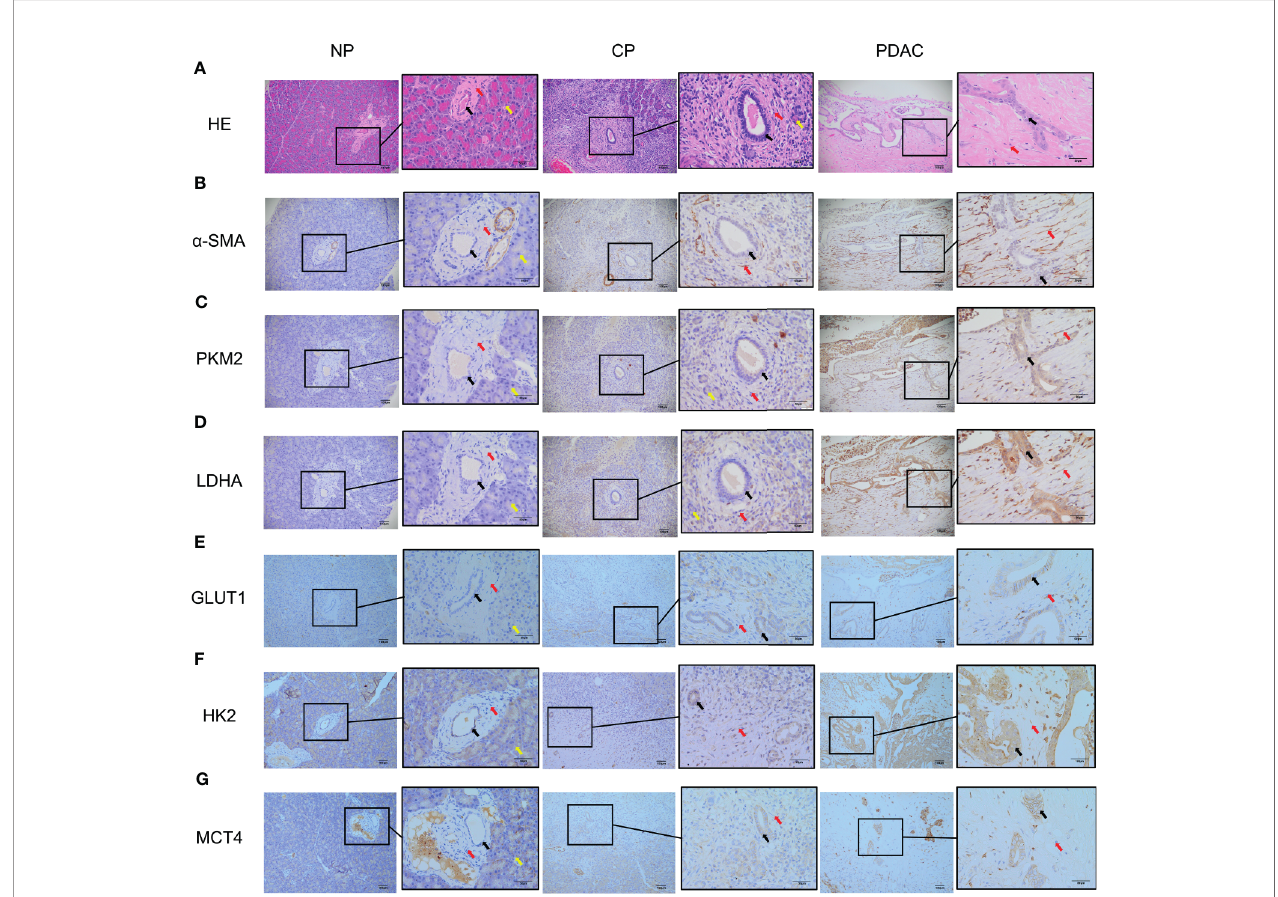
FIGURE 5 | Immunohistochemistry showed that the a -SMA and glycolysis markers in the pancreatic tissues of rats in the normal group, CP group and PDAC group gradually increased (100X and 400X; black arrow: normal/cancer epithelial duct cells; red arrow: stromal cells ( fi broblasts, PSCs); yellow arrow: acinar cells). (A) HE in normal/CP/PDAC rat pancreas; (B) a -SMA in normal/CP/PDAC rat pancreas; (C) PKM2 in normal/CP/PDAC rat pancreas; (D) LDHA in normal/CP/PDAC rat pancreas; (E) GLUT1 in normal/CP/PDAC rat pancreas; (F) HK2 in normal/CP/PDAC rat pancreas; (G) MCT4 in normal/CP/PDAC rat